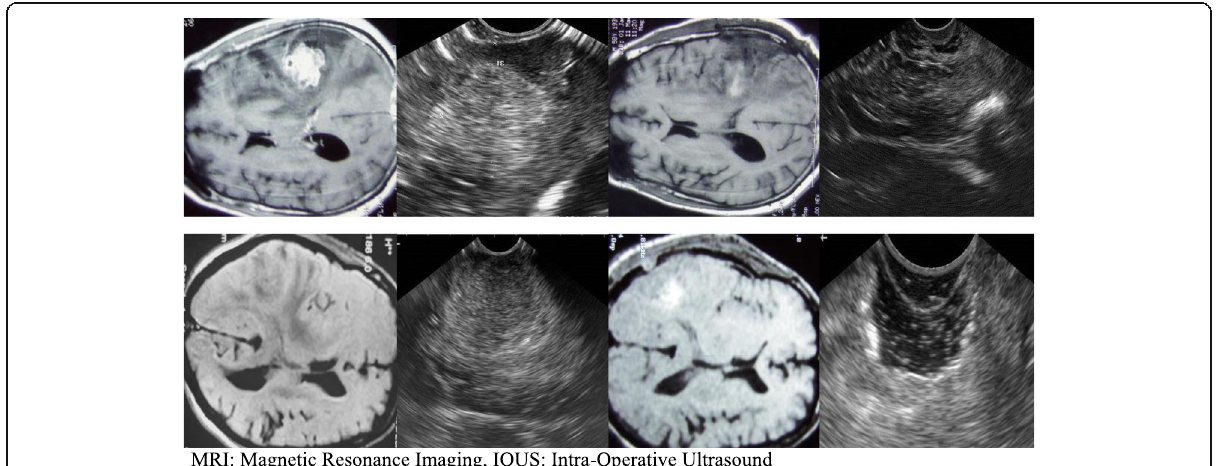
Fig. 9 Gross total resection of metastases (TWO CASES); preoperative and postoperative MRI T1 with contrast and IOUS images